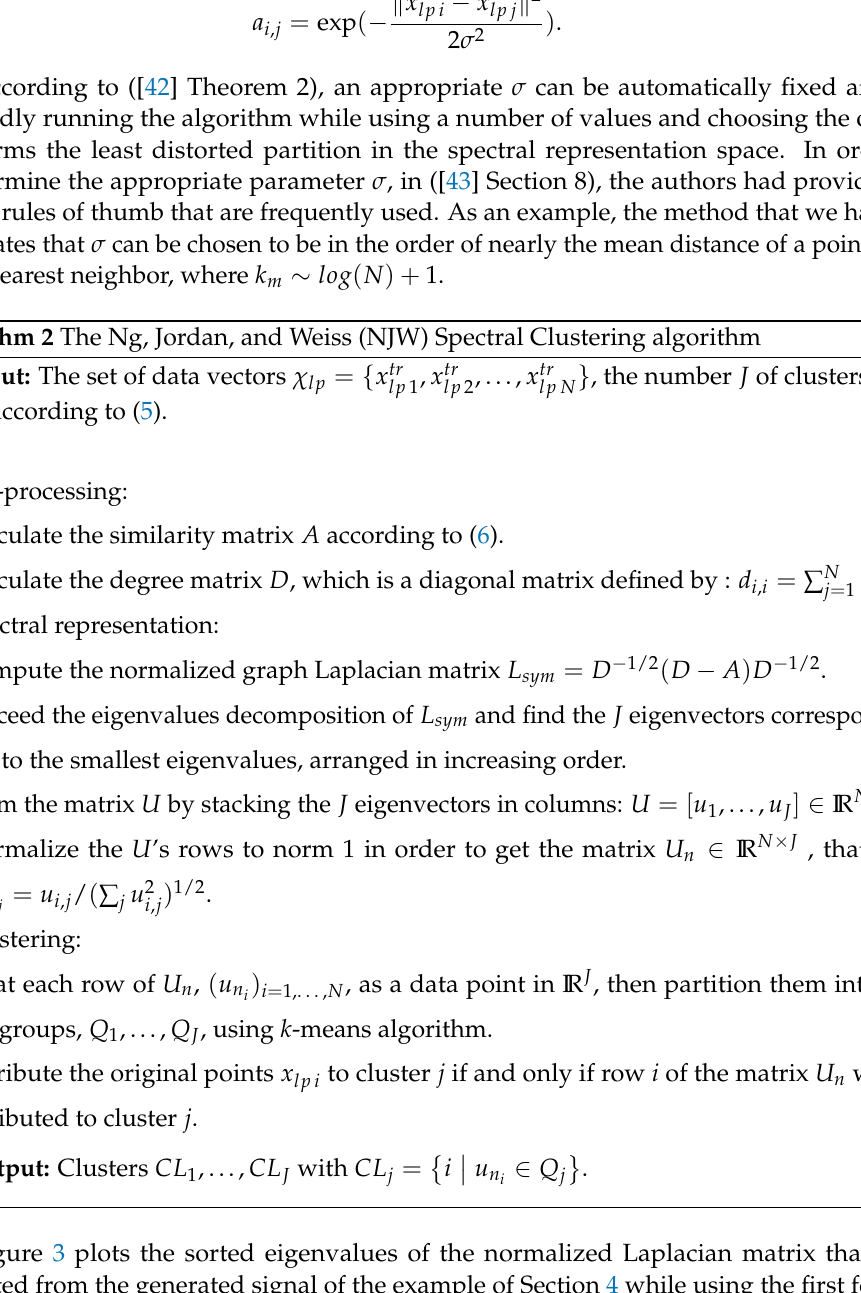
Algorithm 2 The Ng, Jordan, and Weiss (NJW) Spectral Clustering